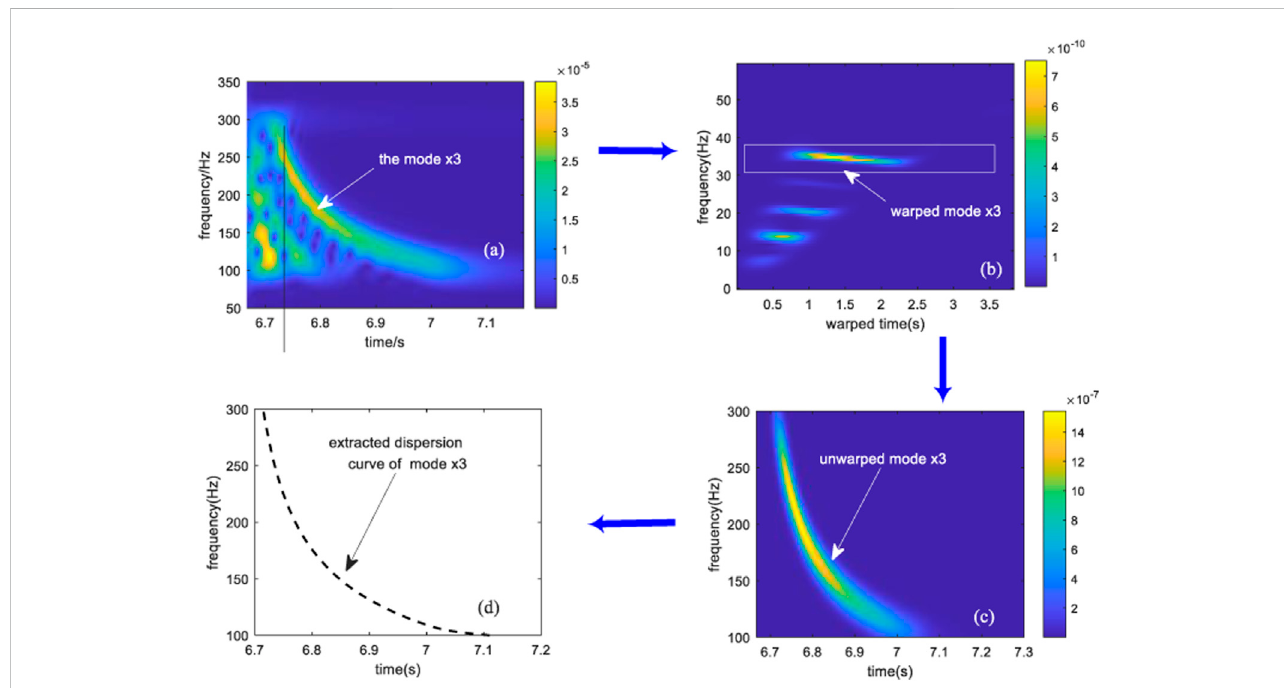
FIGURE 3 Structure of dispersion curve extraction: (A) spectrogram of the received signal; (B) spectrogram of the warped signal; (C) spectrogram of mode x3; (D) dispersion curve of mode x3.